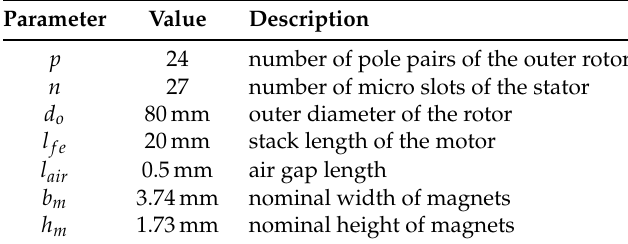
Table 1. Parameters of the Vernier motor shown in Figure 1.